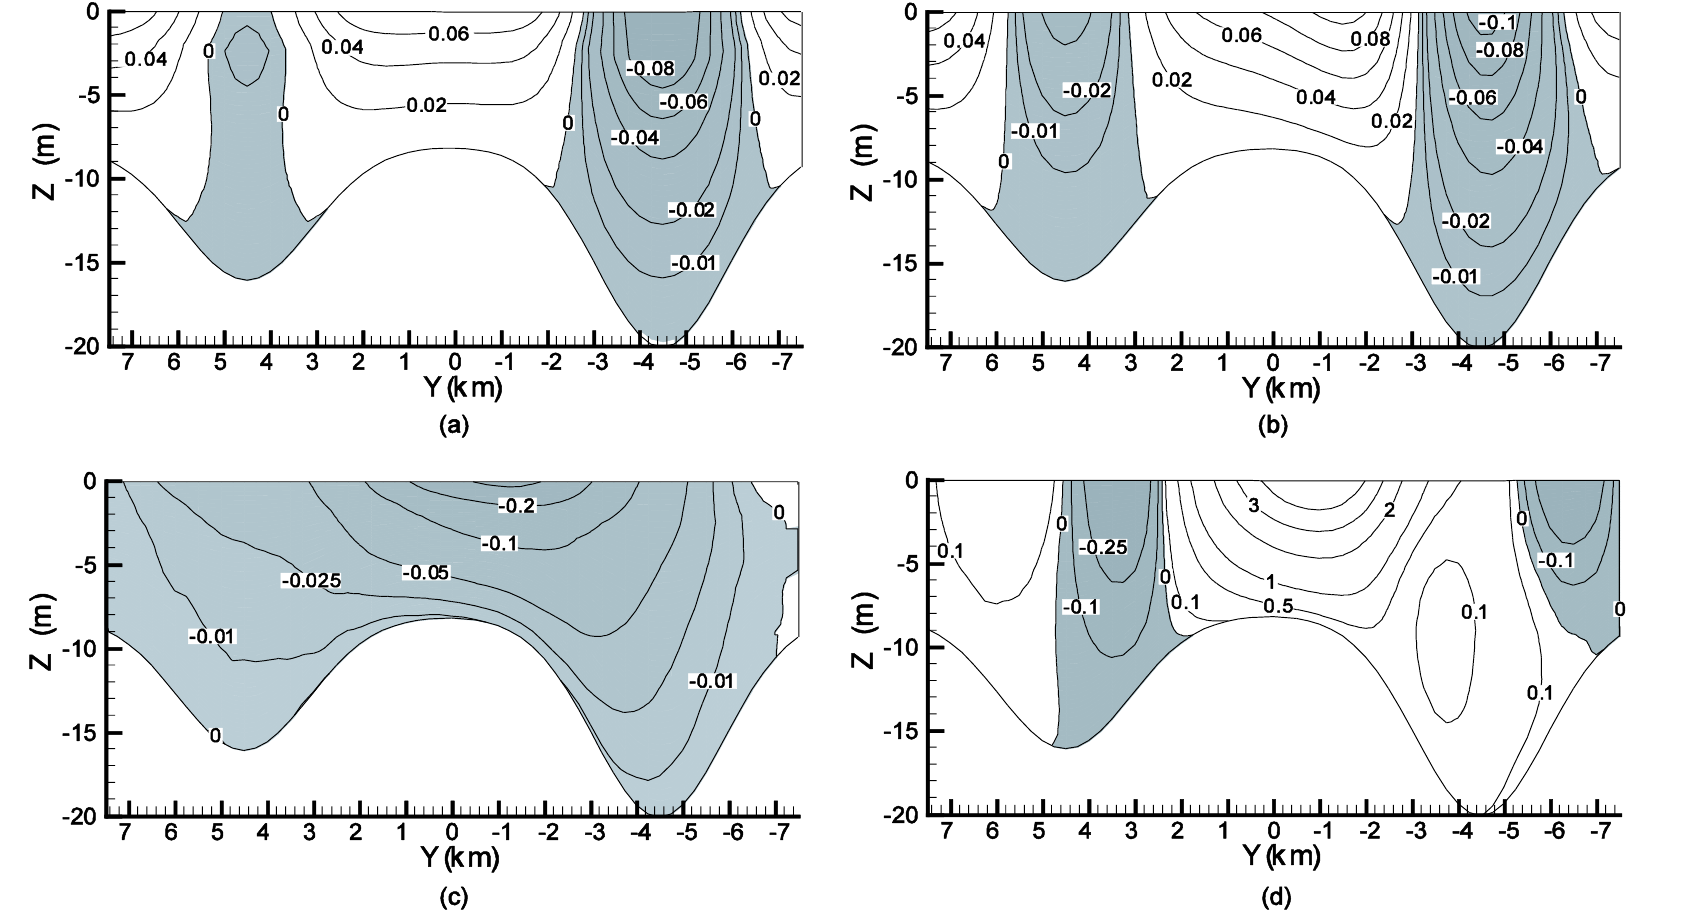
Figure 5. Contours of u x velocity (m/s) at ( a ) x = 50 km and ( b ) x = 98 km and contours of u y velocity (m/s × 10 −2 ) at ( c ) x = 50 km and ( d ) x = 98 km for the wind-driven case. The dark areas represent negative velocities.